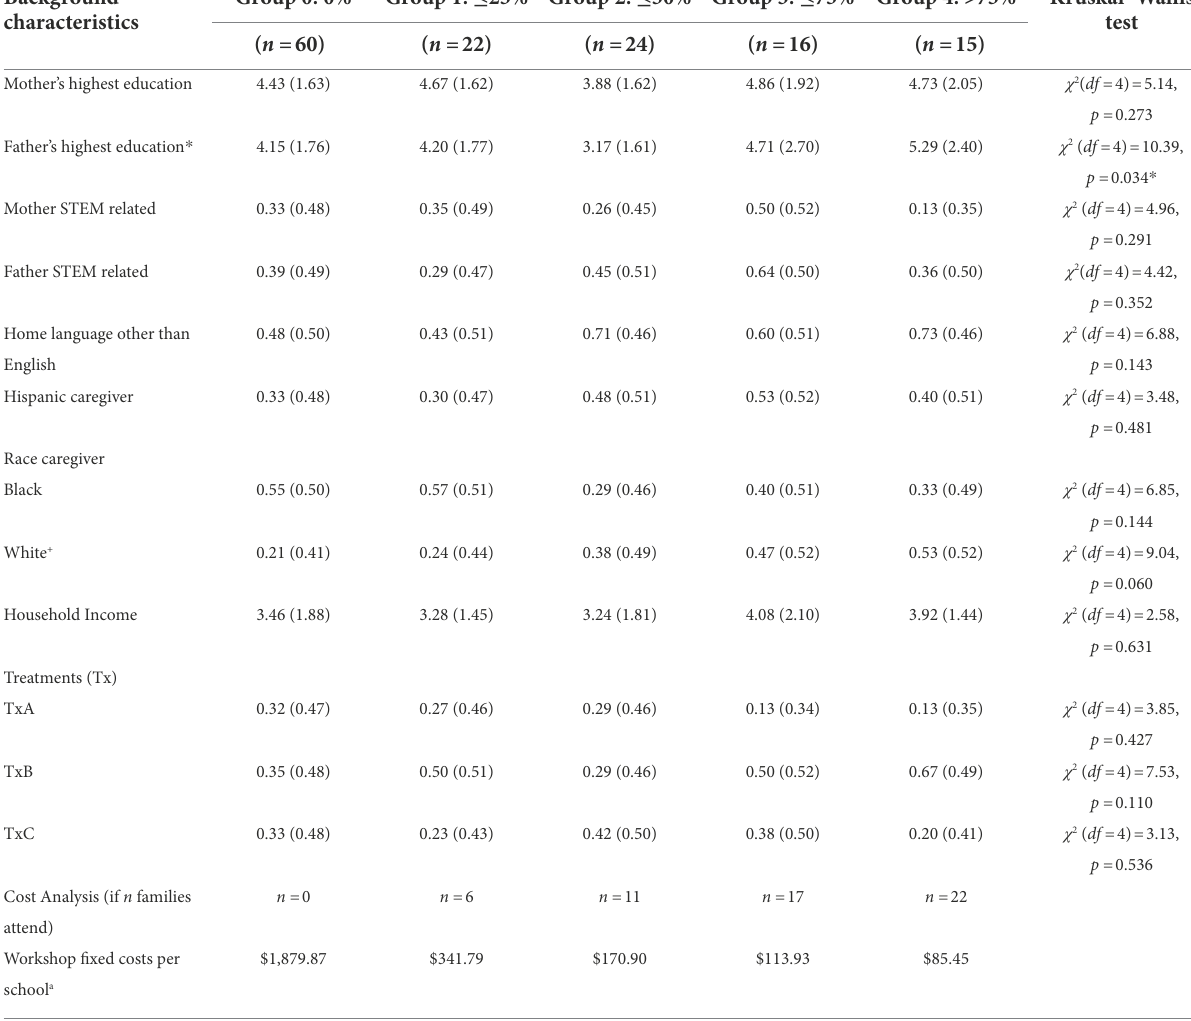
TABLE 2 Workshop attendance.